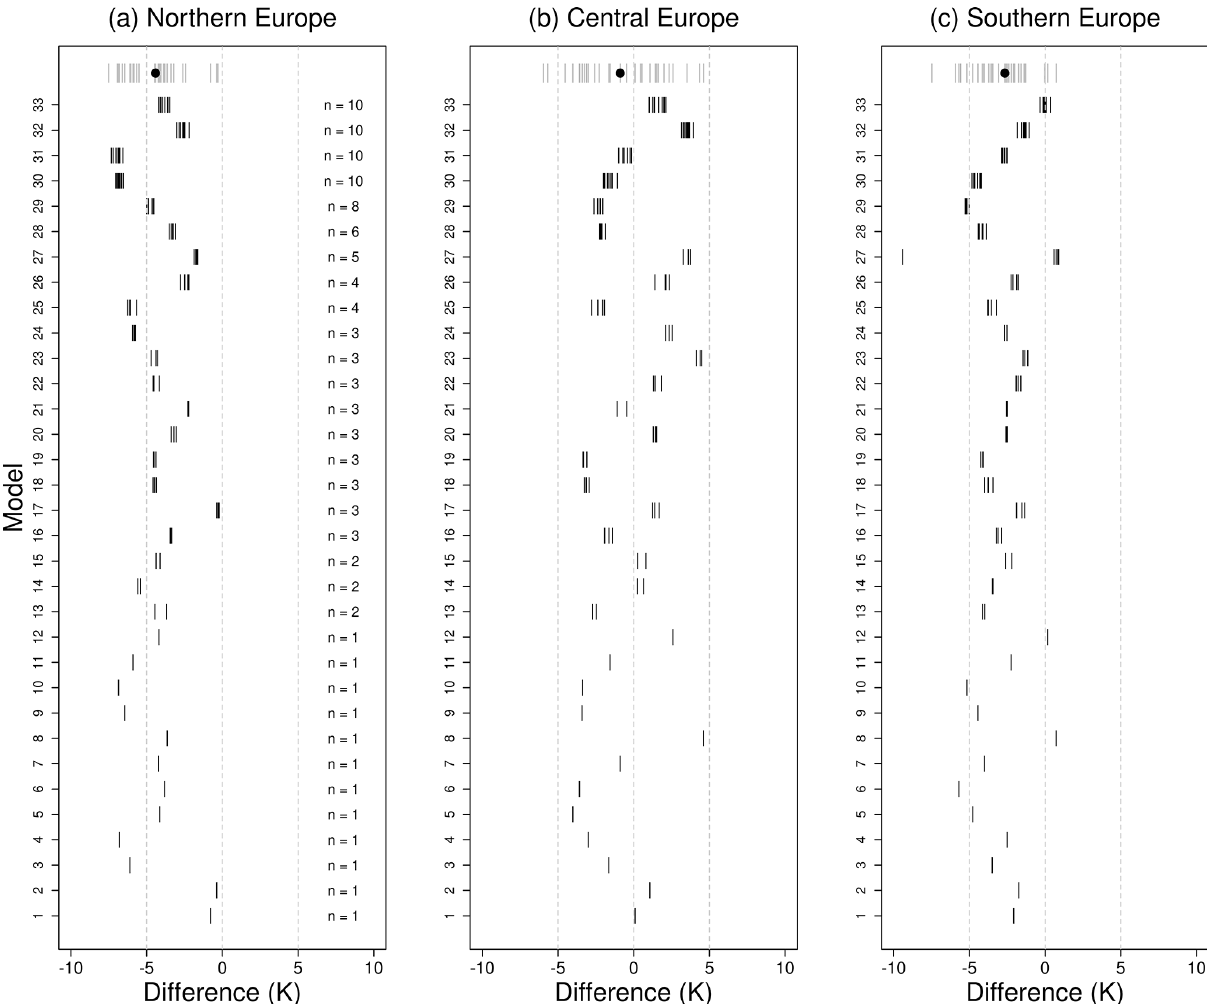
Figure 4. Difference in Tx DS (model – EOBS) calculated for all members of each model ensemble in three regions: (a) northern Europe, (b) central Europe and (c) southern Europe. The first row provides the ensemble mean of each model (grey lines) and the multi-model ensemble median (black dot), while each subsequent row provides the differences for each ensemble member of models 1–33 and the number of members ( n ) in each model ensemble. Models are sorted by number of members in descending